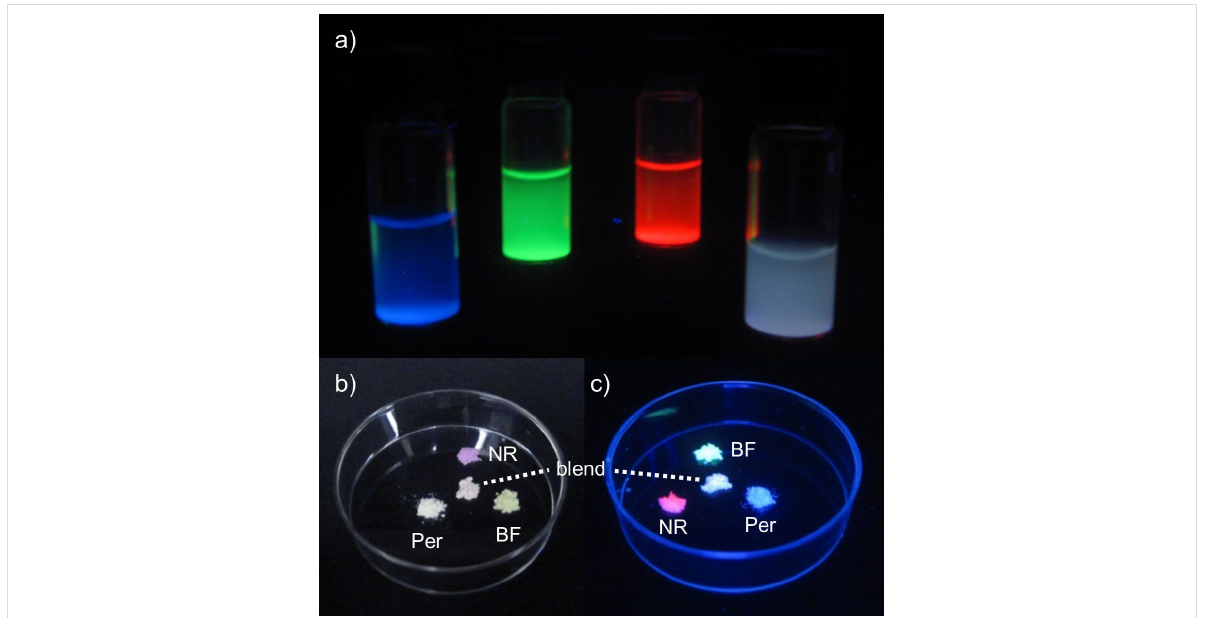
Figure 6: a) Suspensions of the dye-functionalized silica hybrid materials 8@MCM-3 , 9@MCM-3 , and 10@MCM-6 as well as their mixture in dichloro- methane under UV light ( λ exc = 365 nm). b) Solids of dye-functionalized silica hybrid materials 8@MCM-4 , 9@MCM-2 , and 10@MCM-2 as well